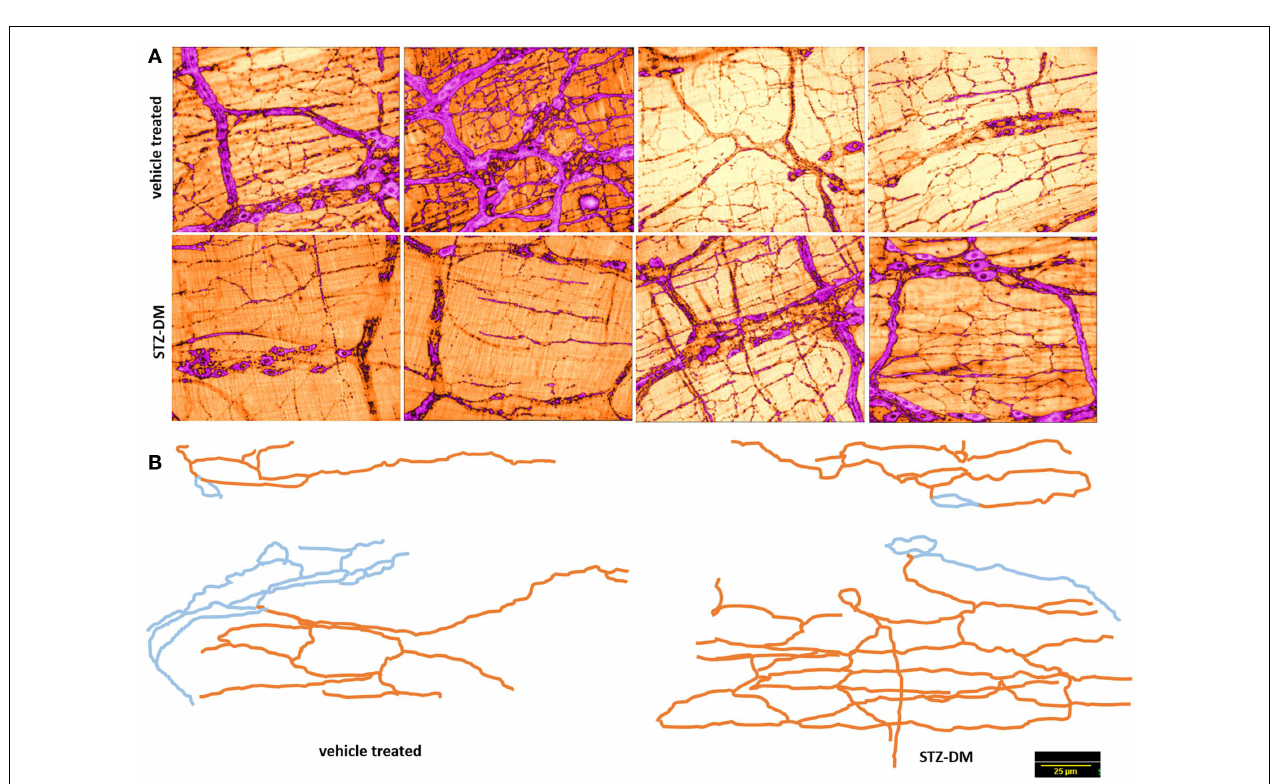
FIGURE 5 | Normal arborization of nitrergic neuronal processes on muscularis in both vehicle treated and diabetes . (A) shows variance in distribution of the nitrergic processes. (B) shows two traced neurons in each group. Note the complex ramifications patterns. Blue indicates cell body and interganglionic neuronal connections. Orange color indicates the neuronal processes extending onto the muscularis. Note that varicosities were not traced. Scale bar, 25 µ m.